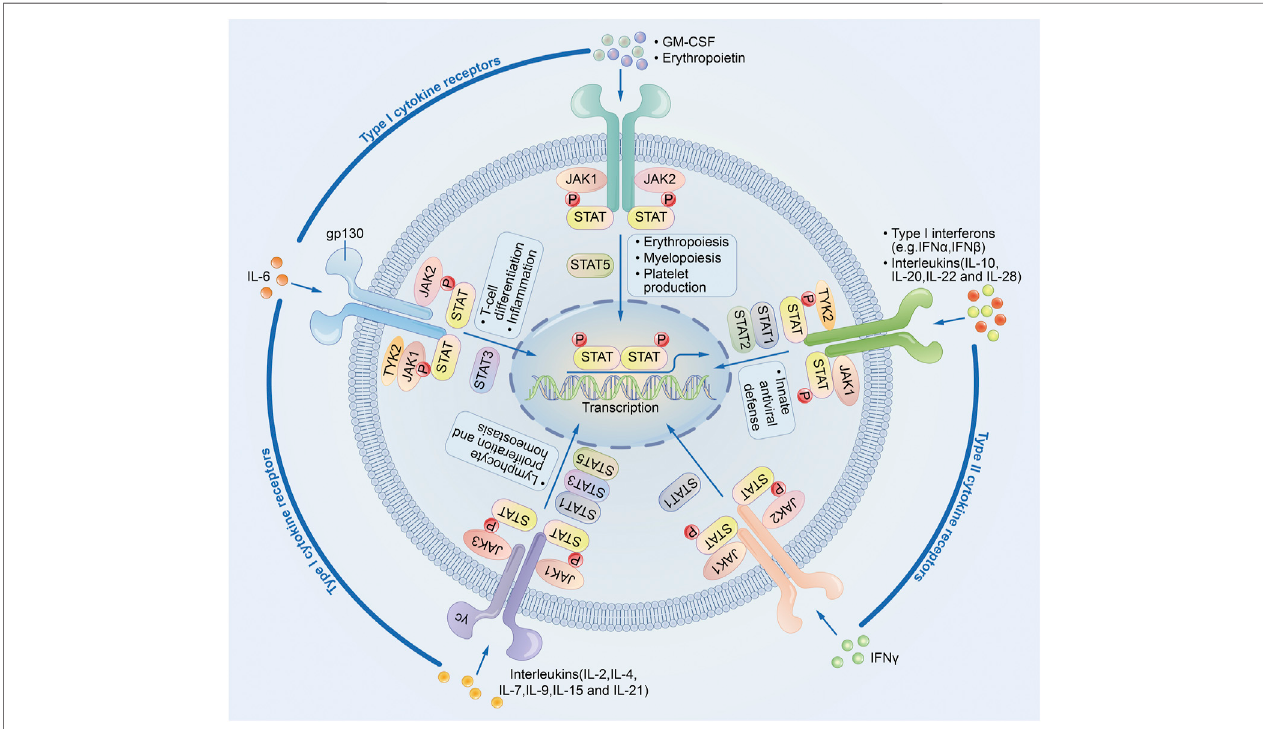
FIGURE 1 | JAK-STAT signaling